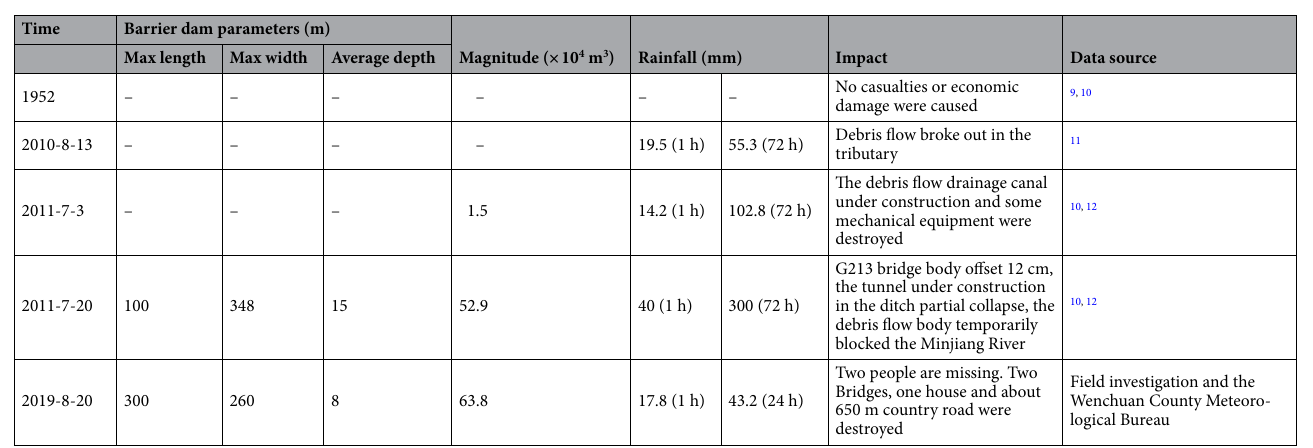
Table 1. Typical debris flow events of Chediguan